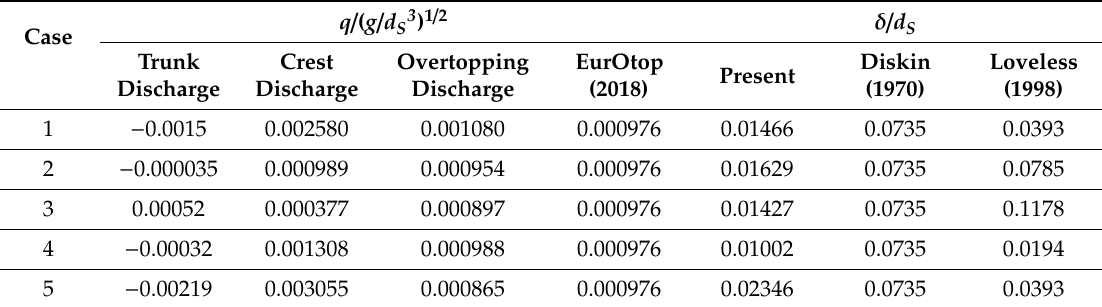
Table 3. Mean overtopping discharge and wave setup for all the ZFB cases (Table